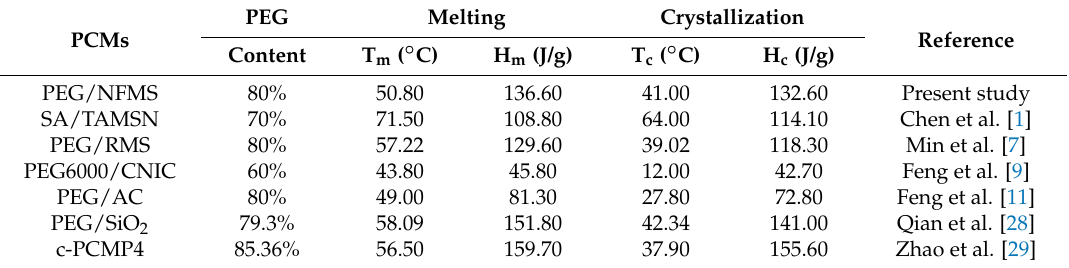
Table 2. Thermal characteristics of different composite phase change materials (PCMs) in the